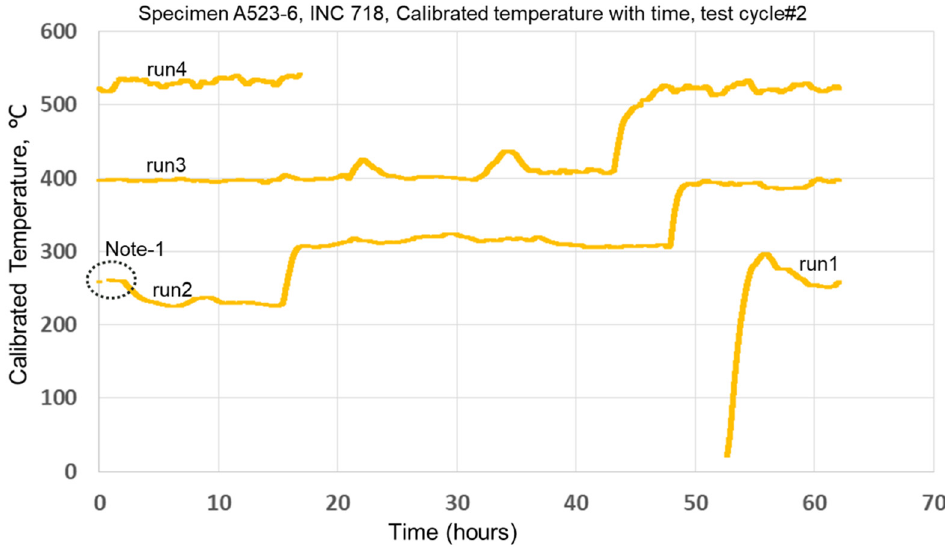
Figure 15. Calibrated temperature measurement using embedded FBG sensor on INC 718 speci- men A523-6 (test cycle#2); Note-1: fixing cable connections during startup.